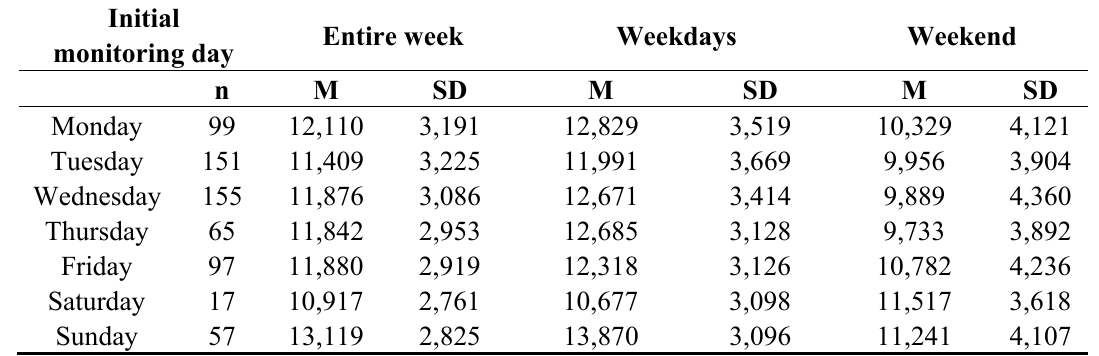
Table 1. Mean number of steps/day averaged across an entire week stratified by the “starting day”.